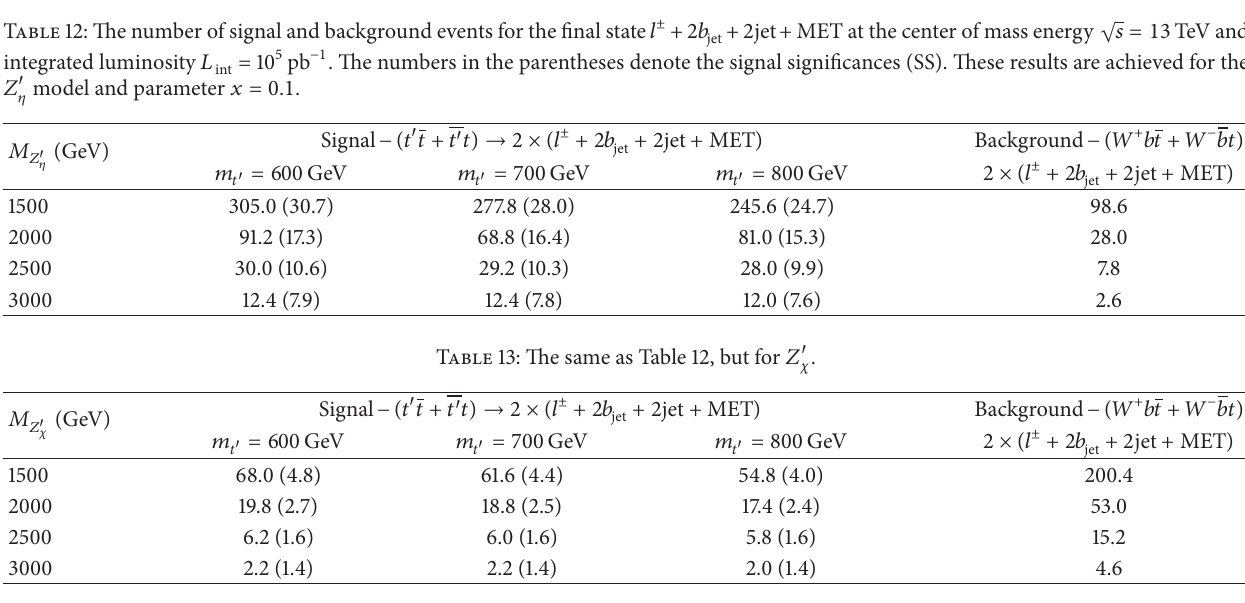
Table 14: The same as Table 12, but for 𝑍 󸀠 𝜓